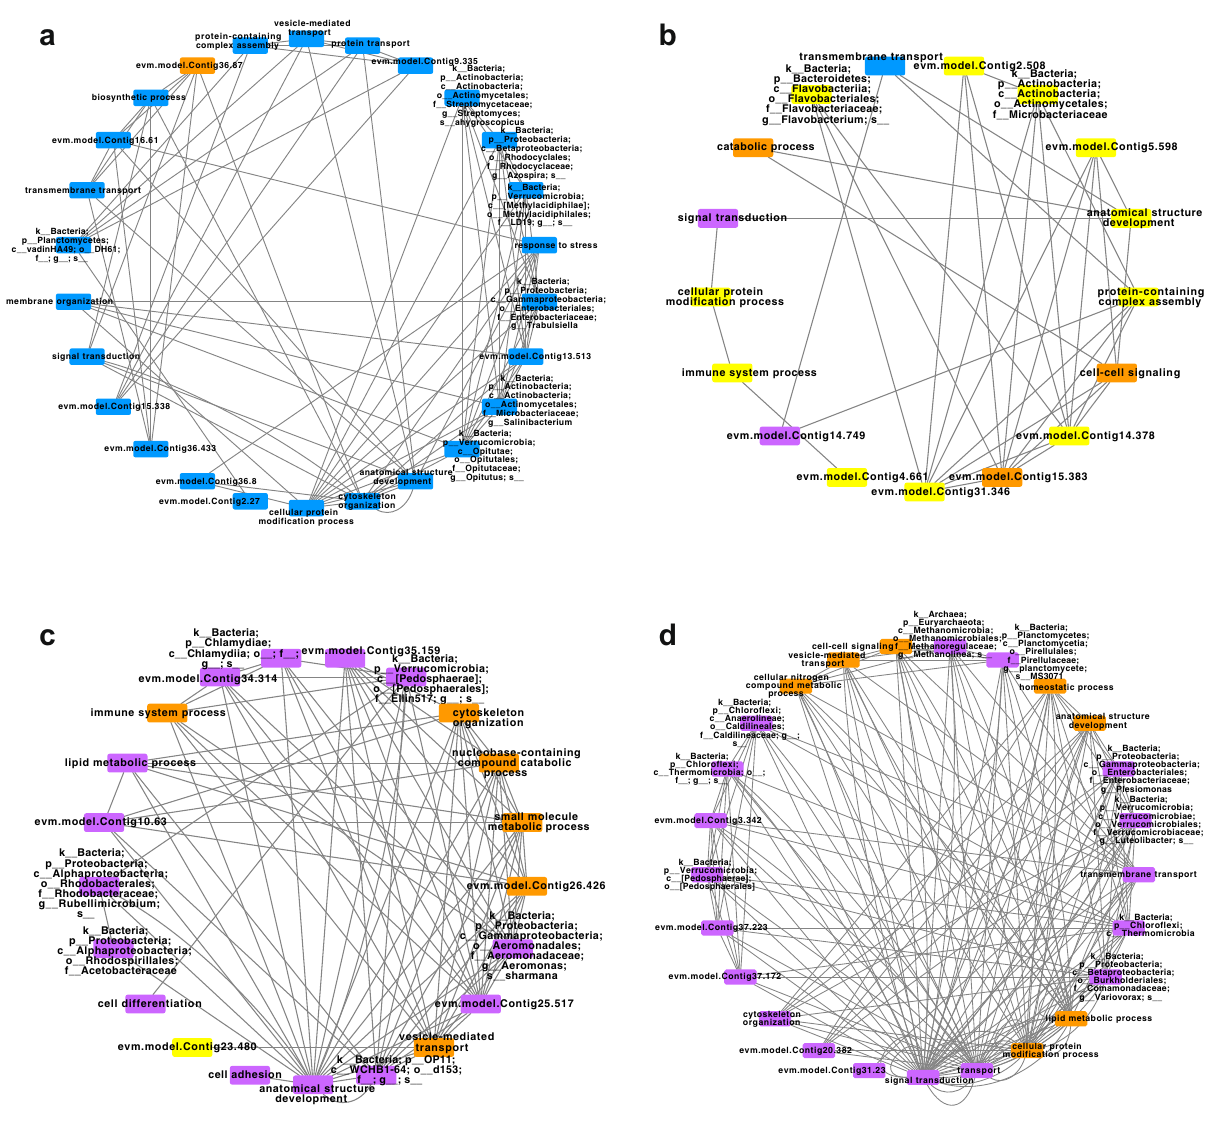
Fig. 5 Interaction motif between Amynthas corticis genome and its gut microbiome. In the fi rst motif ( a ), the second motif ( b ), the third motif ( c ), and the fourth motif ( d ), the ID or GOSlim of the protein element and taxon of the microorganism element were labeled on each node, while the interaction between each two nodes was represented by a gray line connecting them. The node was colored with blue, yellow, orange, or purple if the corresponding element possessed the highest expression or abundance before incubation, on the third, seventh, or twenty-eighth day